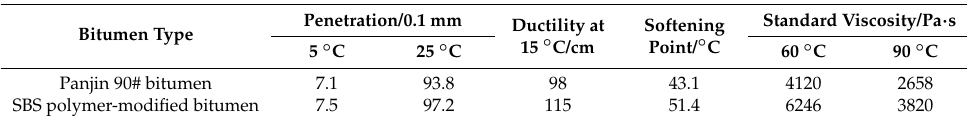
Table 1. Basic Performance Parameters of Panjin 90# Bitumen and Styrene–Butadiene–Styrene (SBS) Polymer-modified